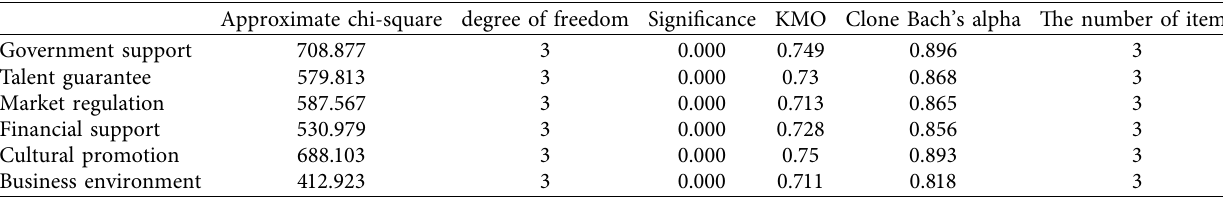
Table 2: Sample reliability validity test.